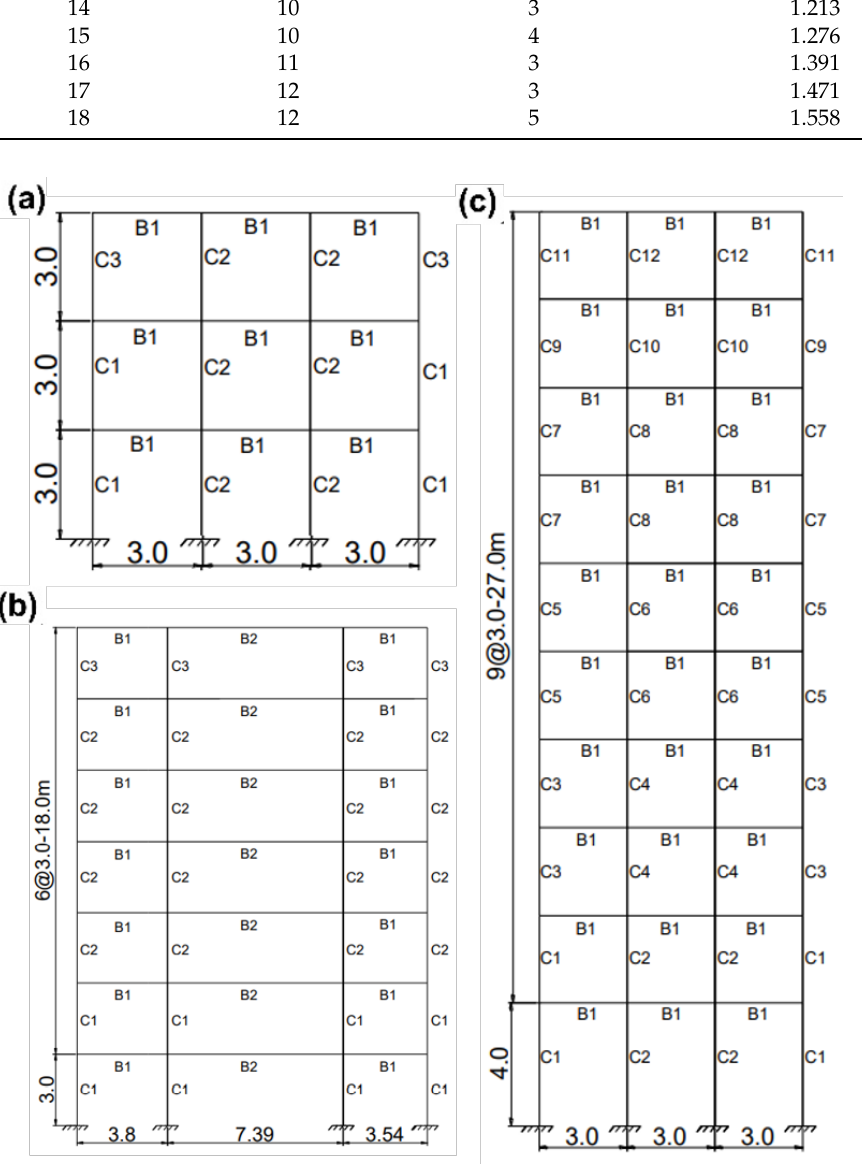
Figure 3. Geometric description of Frames #3, #9 and #14 in Table 2. All dimensions are in meters. ( a – c ) corresponds to short, intermediate and long period structures. Table 3. Sectional properties of Frames #3, #9 and #14 in Table 2.